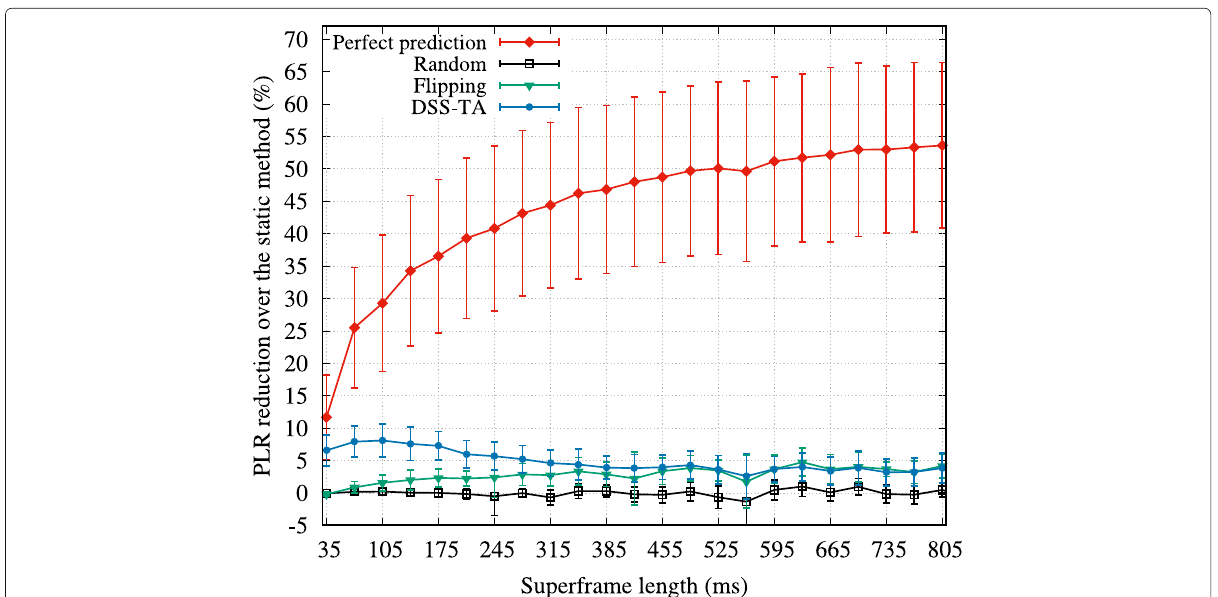
Fig. 15 PLR reduction over the static method vs. superframe length, P Tx = –15